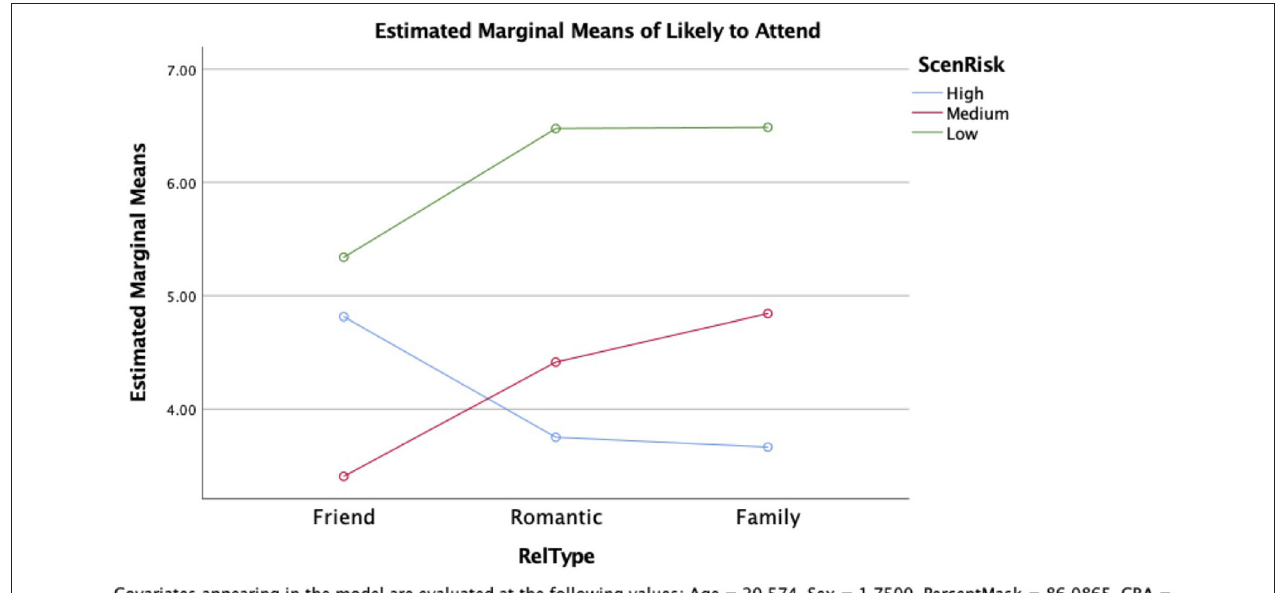
FIGURE 3 | Interaction of relationship type and risk level to predict reported likelihood of attending an event during the COVID-19 pandemic.